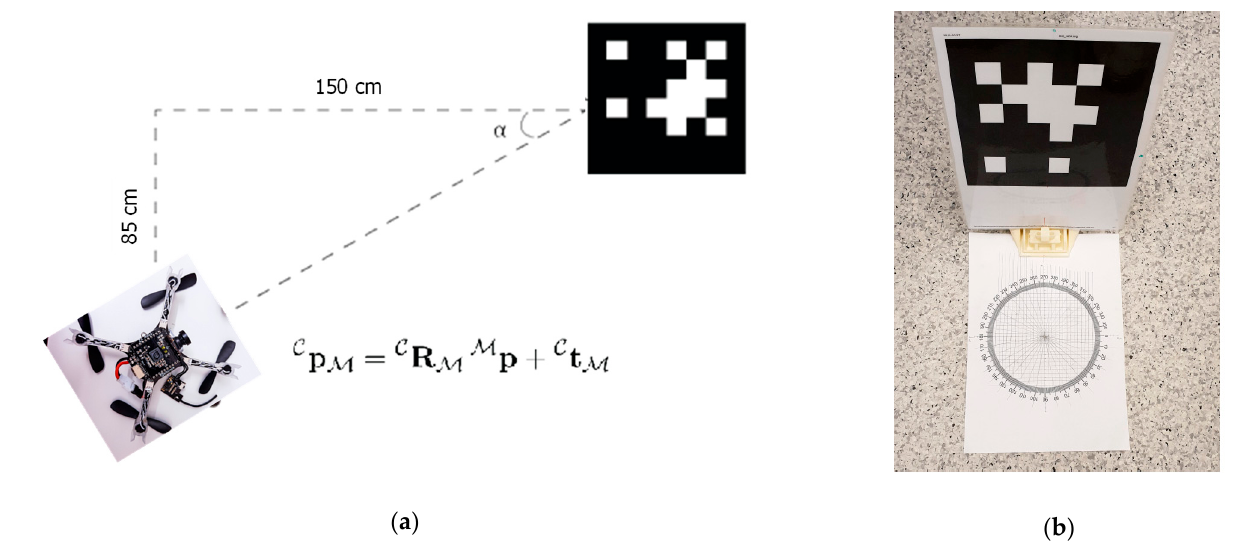
Figure 8. ( a ) The micro aerial vehicle (MAV) is located 1.5 m away from the target location and a rotation of 30 degrees; ( b ) image of the selected ArUco marker and measurement pad for target landing.